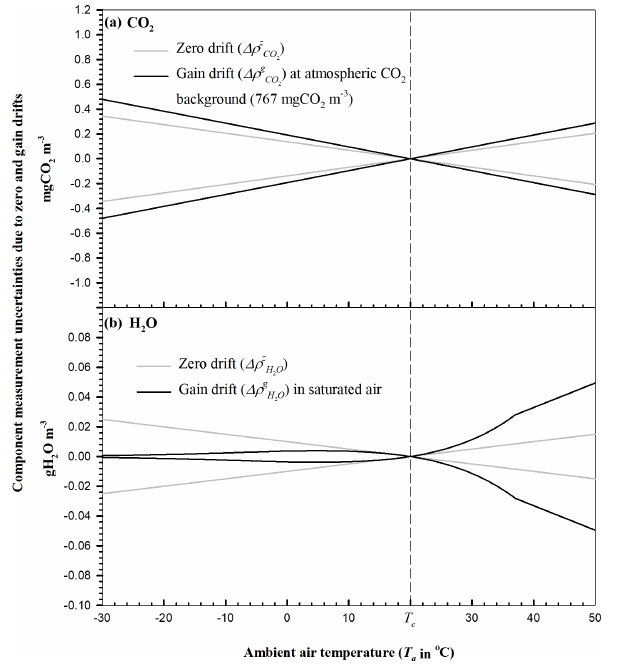
Figure 4. Component measurement uncertainties due to the zero and gain drifts of EC150 infrared CO 2 –H 2 O analyzers (Campbell Scientific Inc, UT, USA) in open-path eddy-covariance flux systems over their operational range in T a under an atmospheric pressure of 101.325kPa. The vertical dashed line represents the ambient air temperature ( T c ) at which an analyzer was calibrated, zeroed, and/or